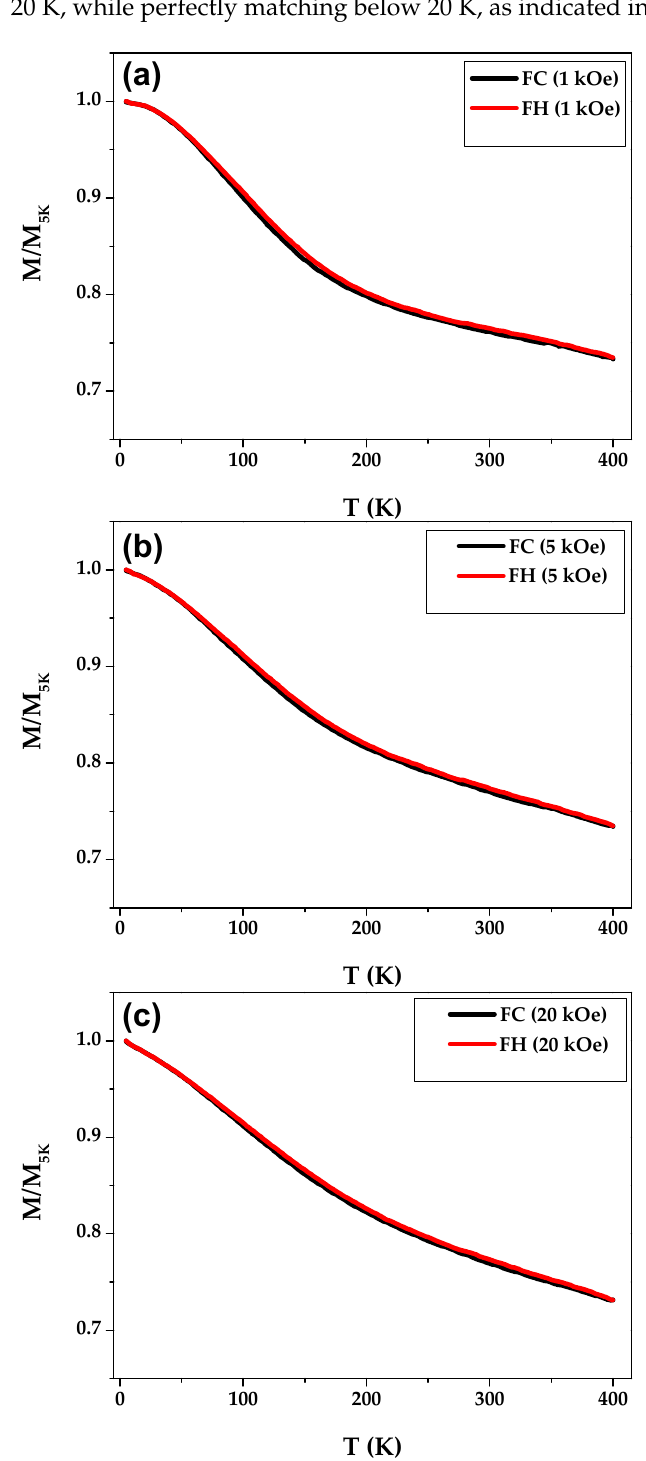
Figure 6. Measured temperature dependence of magnetization for the as-prepared Co 2 MnGe glass- coated microwires, with 1 kOe ( a ), 5 kOe ( b ), and 20 kOe ( c ) of applied external magnetic fi eld. The thermomagnetic properties, i.e., M/M 5K vs. T, and magnetic fi eld of the Co 2 MnGe glass-coated microwires, are shown in Figures 5 and 6. In this part, we only focused on the magnetization behavior at a wide range of temperatures and magnetic fi elds to eval- uate the possible magnetic phase transition. We measured temperature dependencies of